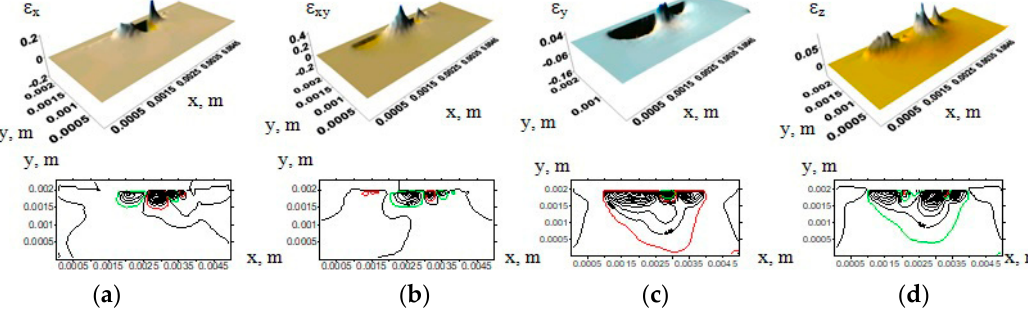
Figure 5. Strain tensor component distribution surfaces and their corresponding contours in uniform (neat) samples under normal and tangential loads: ( a ) ε x ; ( b ) ε xy ; ( c ) ε y ; ( d ) ε z . In the case of tribological loading of the samples filled with 5% (vol.) inclusions (Figure 6b), the maximum strains were predominantly developed in the upper layer of the computational domain.